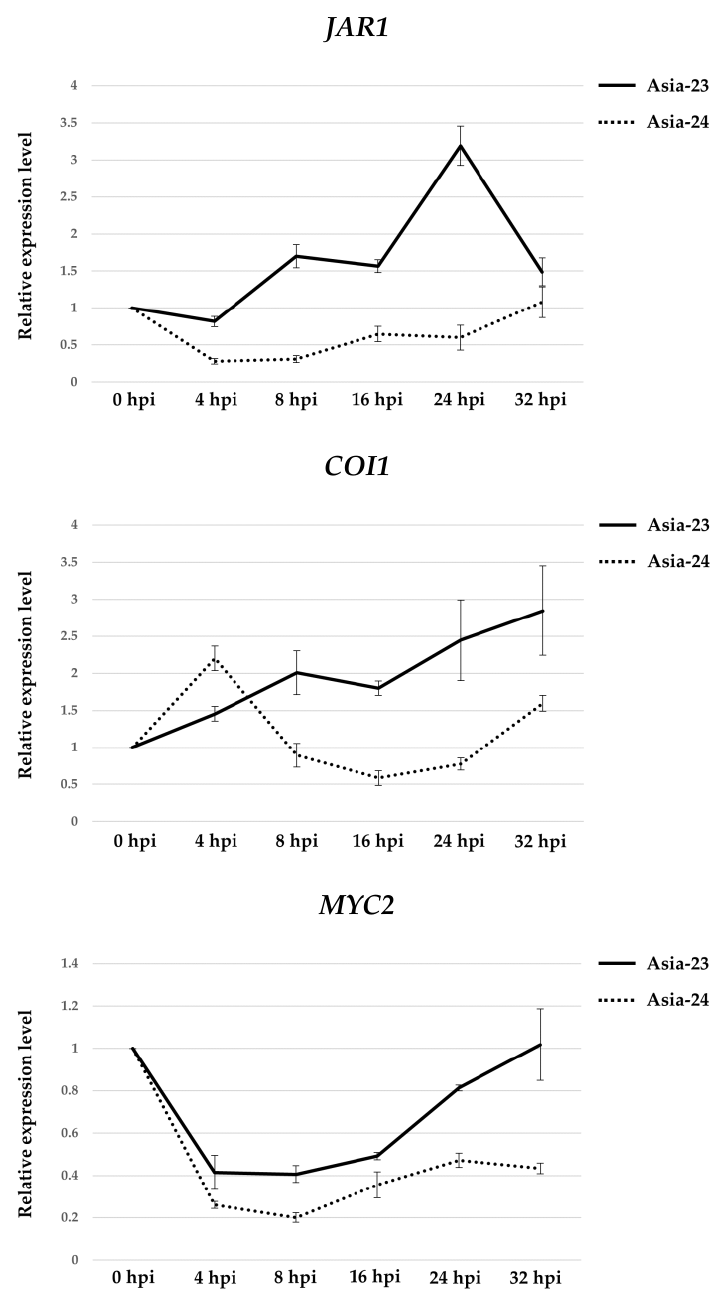
Figure 5. Comparison of time-series gene expression pattern of each selected gene in Asia-23 and Asia-24 by qRT-PCR. The solid line shows the time-series gene expression pattern of Asia-23, the dotted line represents the time-series gene expression of Asia-24. The relative expression levels of samples at different time points (hpi) were calculated using the 2 − ∆∆ Ct method, which compared the ∆ Ct values of each sample (hpi) with the ∆ Ct values at 0 hpi. Error bars indicate the standard deviation of three biological replicates. Hpi: hours post inoculation.